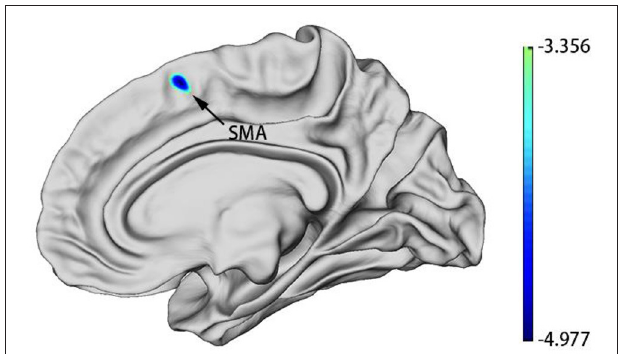
FIGURE 1 | MDD group patients showed decreased cortical thickness of SMA in the right hemisphere at baseline. Blue regions represent areas of decreased cortical thickness. TABLE 3 | Difference in the cortical thickness of the right hemisphere between the MDD group and the HC group at baseline. Brain region HCP